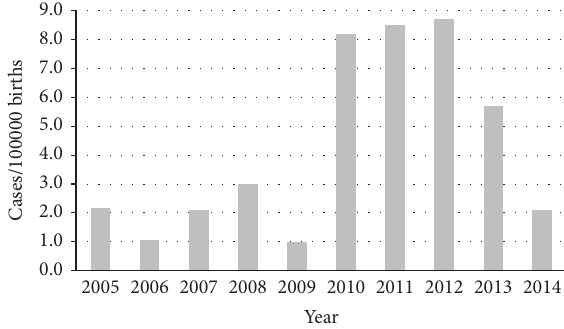
Figure 1: Number of pregnancy-related listeriosis per 100000 births observed in Lombardy, Italy, from 2005 to